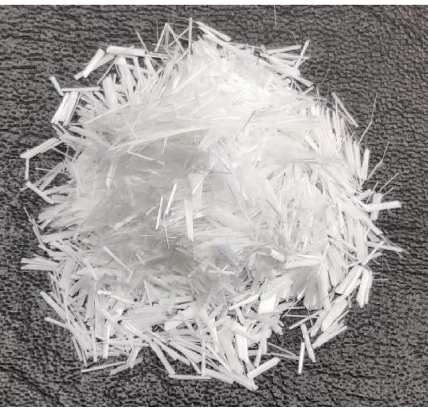
Figure 2: Glass fber photo.